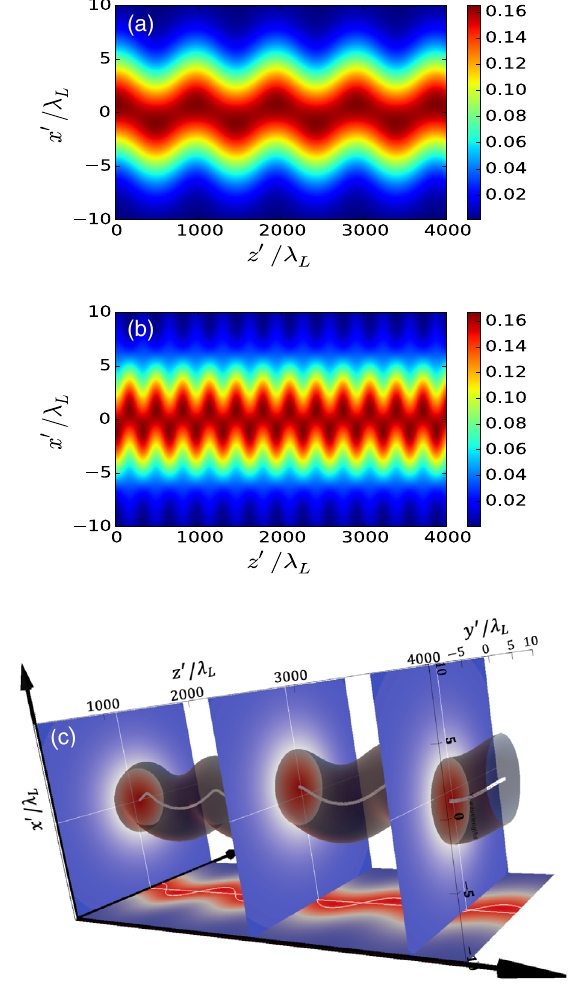
FIG. 1. Integrated transverse intensity profile of laser pulse as a function of propagation distance Z 0 = λ for (a) a fundamental L mode plus a first-order Hermite-Gaussian mode; (b) a funda- mental mode plus a third-order Hermite-Gaussian mode; (c) a fundamental mode plus two first-order Hermite-Gaussian